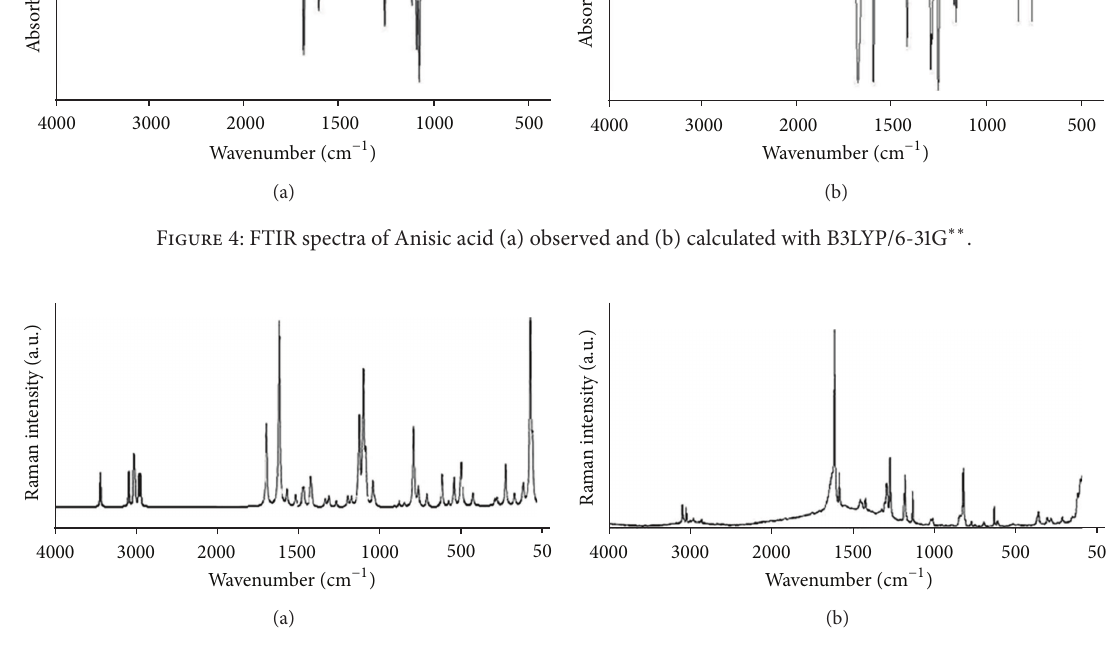
Figure 5: FT-Raman spectra of Anisic acid (a) observed and (b) calculated with B3LYP/6-31G ∗∗